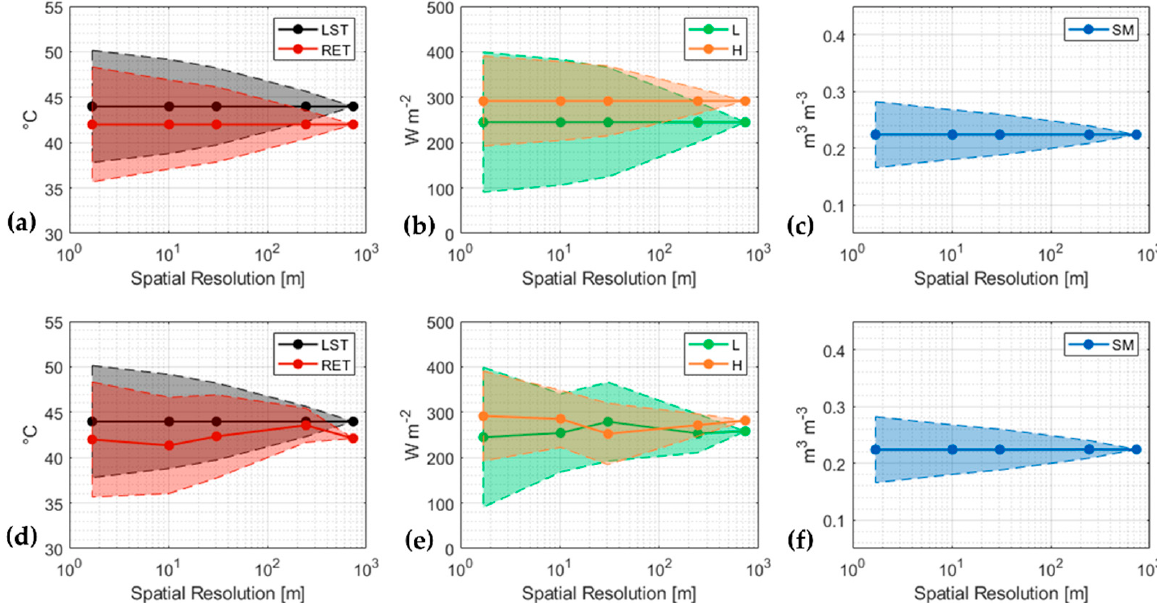
Figure 9. Average (solid line) and Standard Deviation (shaded area) of the remotely-sensed Land Surface Temperature (LST) some FEST-EWB outputs: Representative Equilibrium Temperature (RET, a , d ), Latent (L) and Sensible Heats (H, b , e ) and Soil Moisture (SM, c , f ). Data from the Upscaled Outputs approach (upper row, a – c ) and the Upscaled Inputs approach (lower row, d – f ).